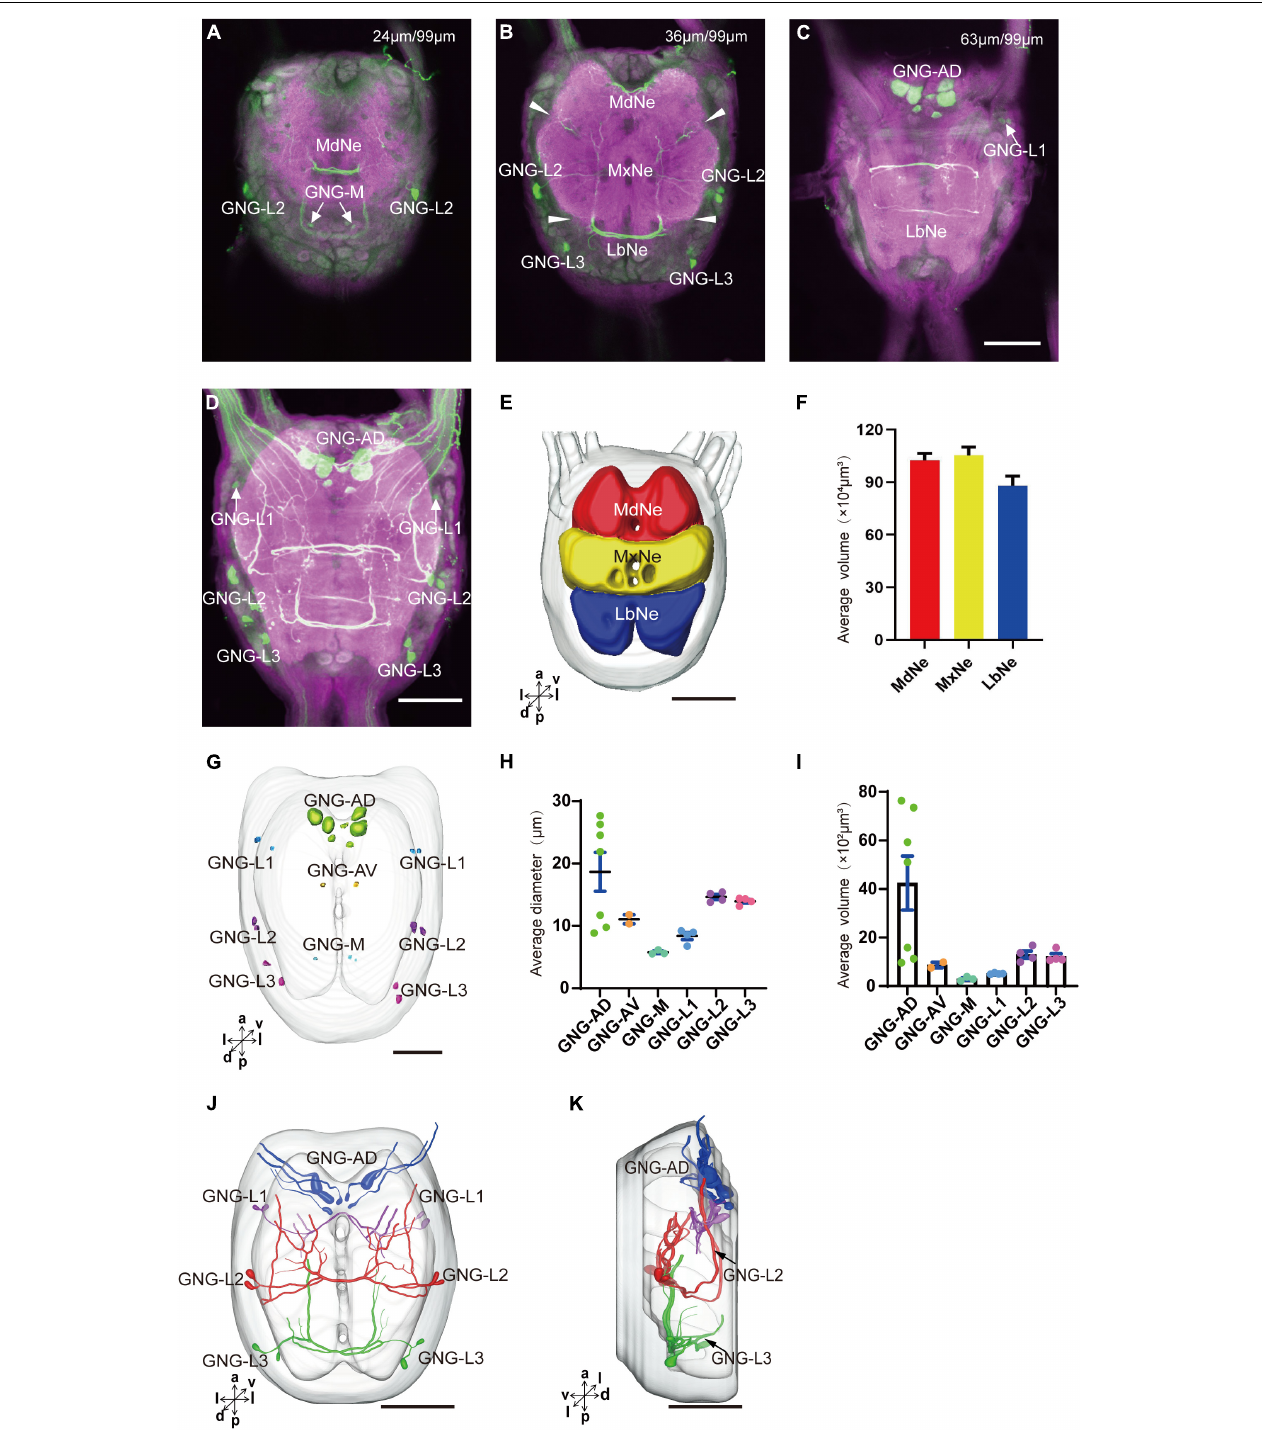
FIGURE 6 | Neuromeres, cell bodies, and processes of the serotonergic neuron in the gnathal ganglion. (A–C) Confocal images showing the distribution of the serotonergic neuron processes and cell bodies in the gnathal ganglion. (D) The confocal stack images of gnathal ganglion. (E) Three-dimensional reconstructions of main neuromeres in gnathal ganglion. (F) The average volume of main neuromeres. (G) The location of cell bodies in gnathal ganglion. (H,I) The average diameter and volume of cell bodies in gnathal ganglion. (J,K) Three-dimensional reconstructions of the serotonergic neurons in the cluster of gnathal ganglion in anterior and lateral view. GNG-AD, GNG-AV, GNG-M, GNG-L1, GNG-L2, and GNG-L3 are cell clusters. MdNe, mandibular neuromere, MxNe, maxillary neuromere, LbNe, labial neuromere. Directions: a, anterior; d, dorsal; l, lateral; m, medial; p, posterior; v, ventral. Scale bars, 100 µ m.